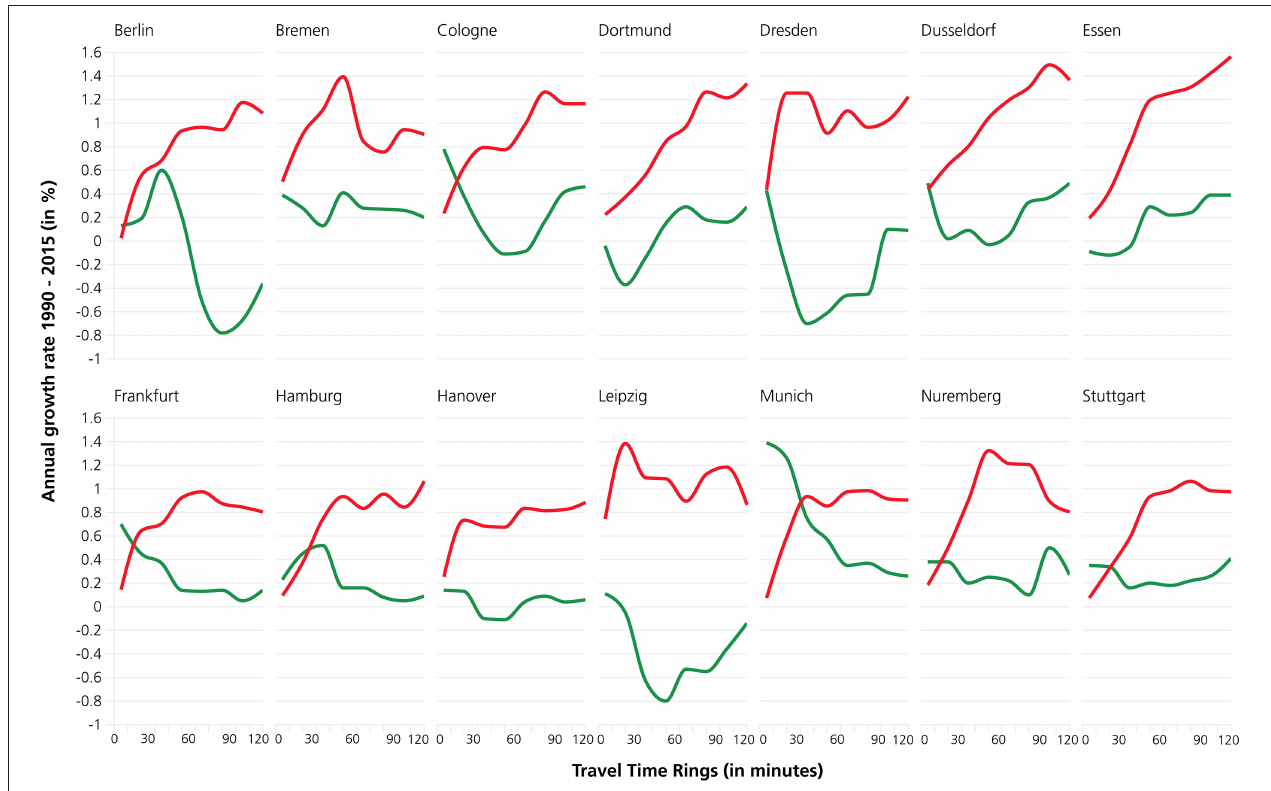
FIGURE 5 | Built-up and population growth rates for selected city regions in Germany (Graphic: C.